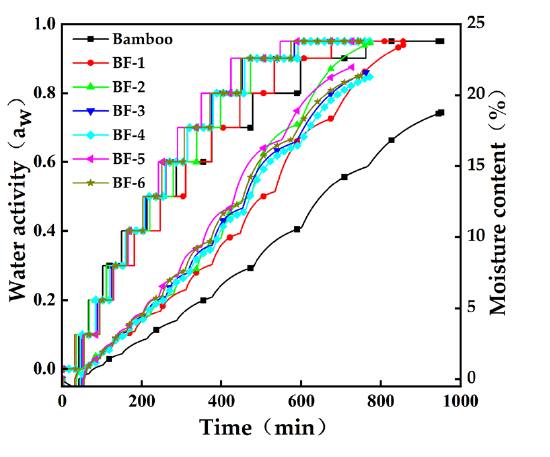
Table 2. Moisture-adsorption equilibrium parameters of bamboo fibers with different opening times.